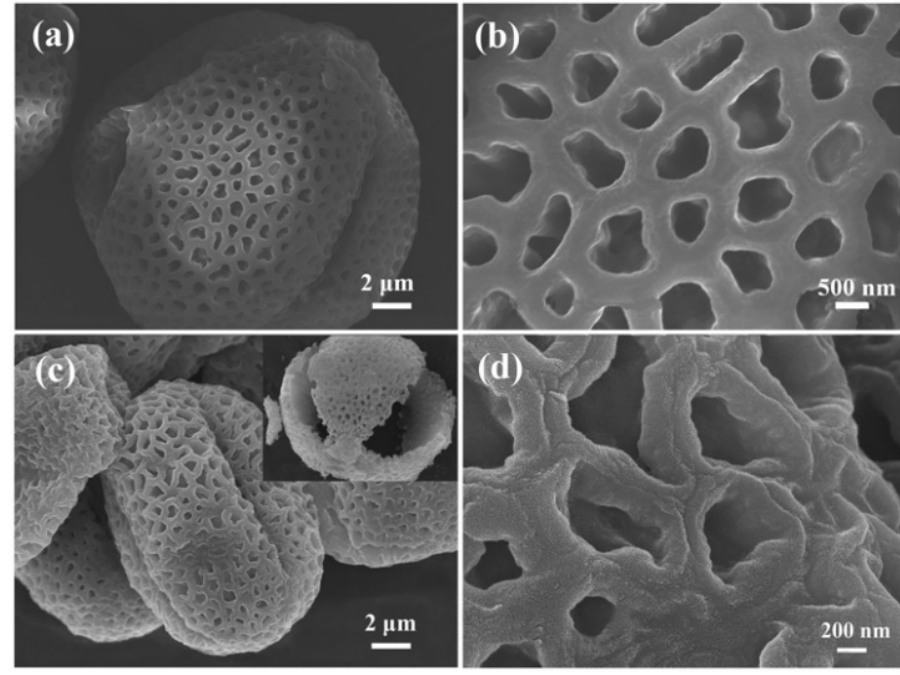
Figure 1. SEM images of RP ( a , b ) and RP-derived C ( c , d ) at low and high magnification.